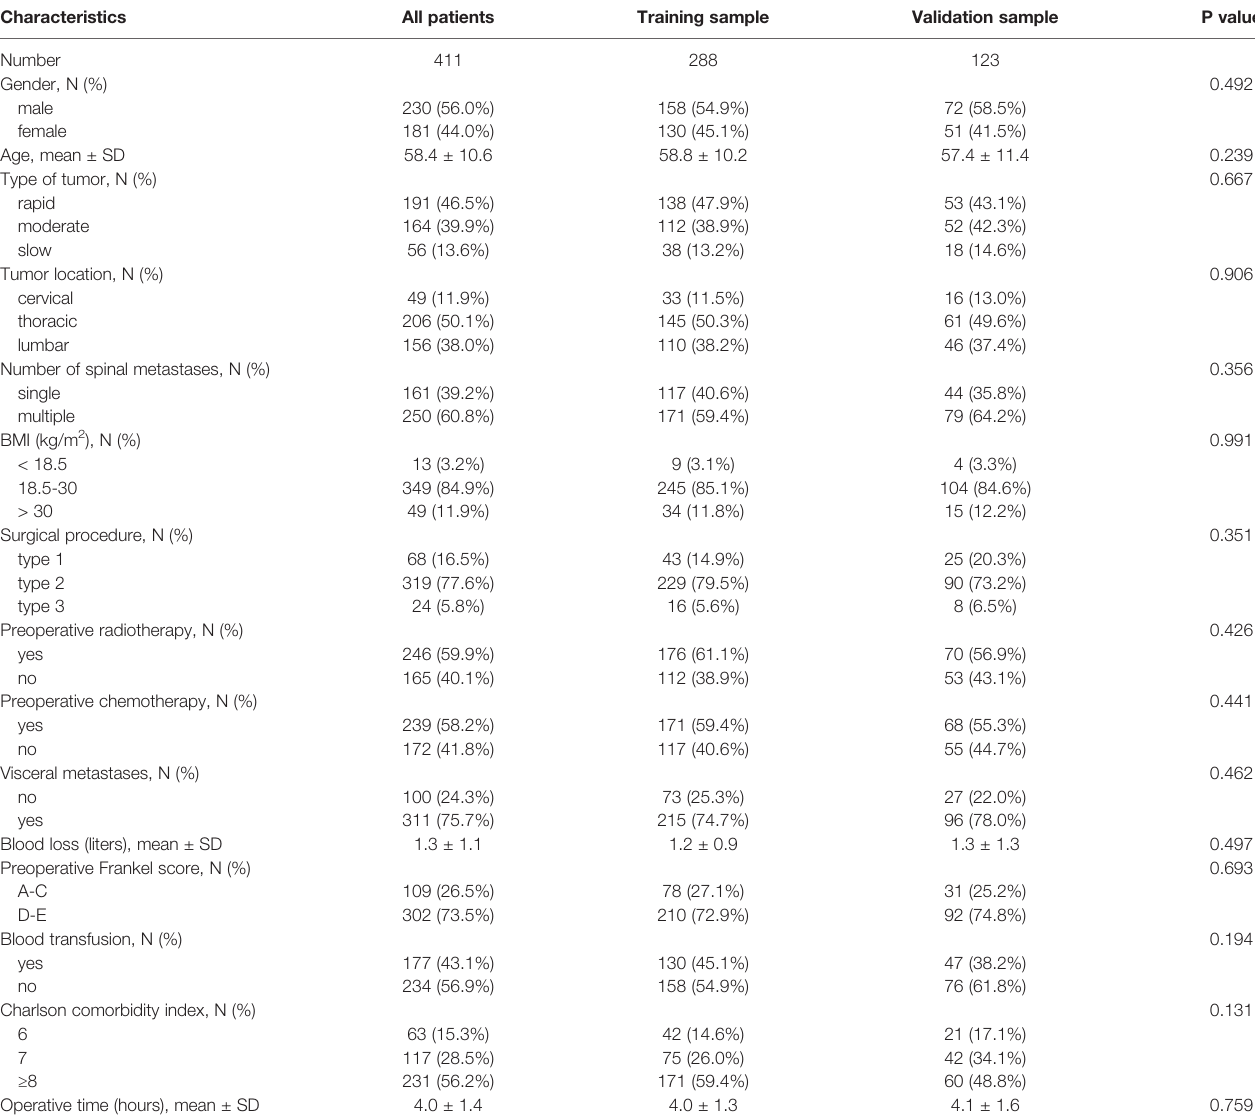
TABLE 1 | Baseline characteristics of the study population.